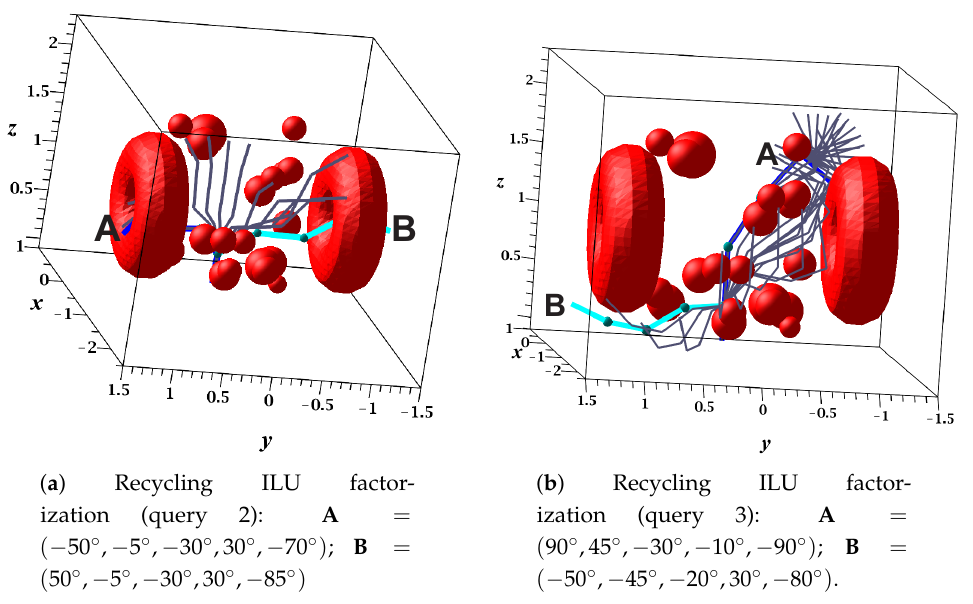
Figure 16. Recycled collision-free paths of the five-DOF manipulator.